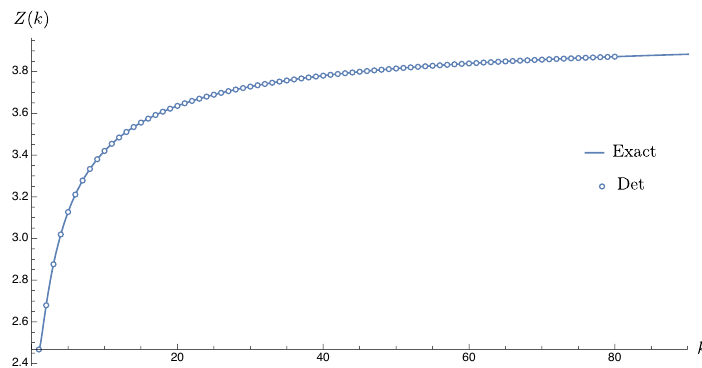
Figure 8 . Plot of Z ( k ) = e F ( k ) for k ∈ [1 , 90] . The data points are obtained by extrapolating numerically the determinant at large m, n for z = ¯ z = − 1 and k ∈ { 1 , 80 } . The solid line is obtained using the parametric representation, eqs. (3.70) and (3.71). Z ( k ) is seen to be monotonic and bounded by Z (1) = π 2 / 4 = 2 . 4674 . . . and Z ( ∞ ) = 4